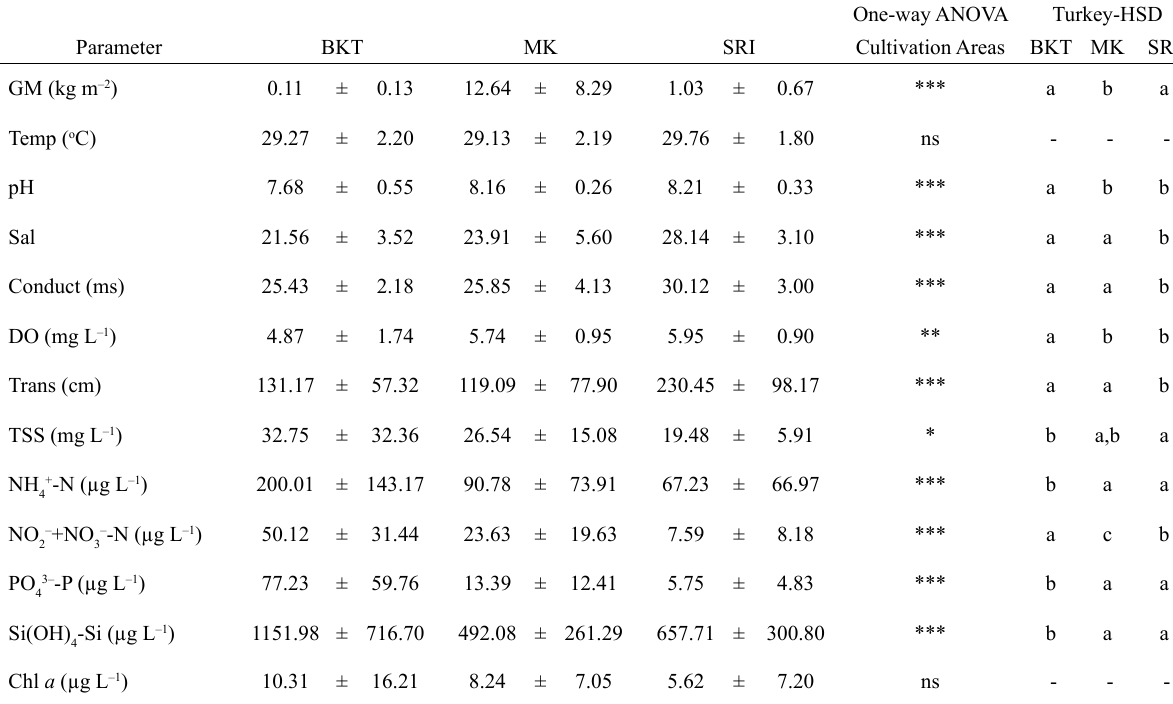
Table 2. – Green mussel production and seawater parameters (mean±sd, n=36) in the green mussel cultivation area at Bang Khun Tien (BKT), Maeklong River Mouth (MK), and Sriracha